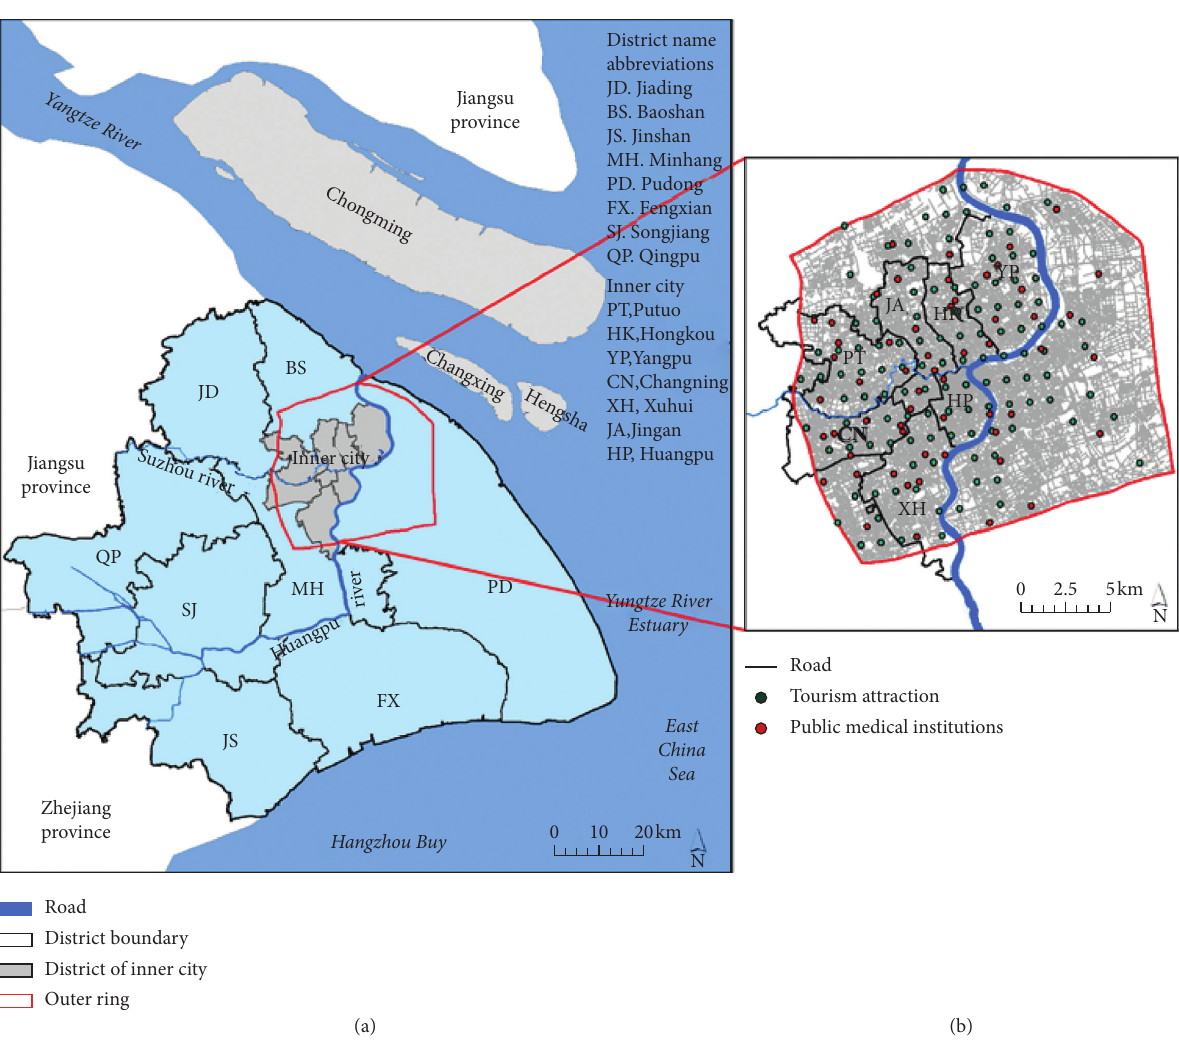
Figure 1: Location of the research